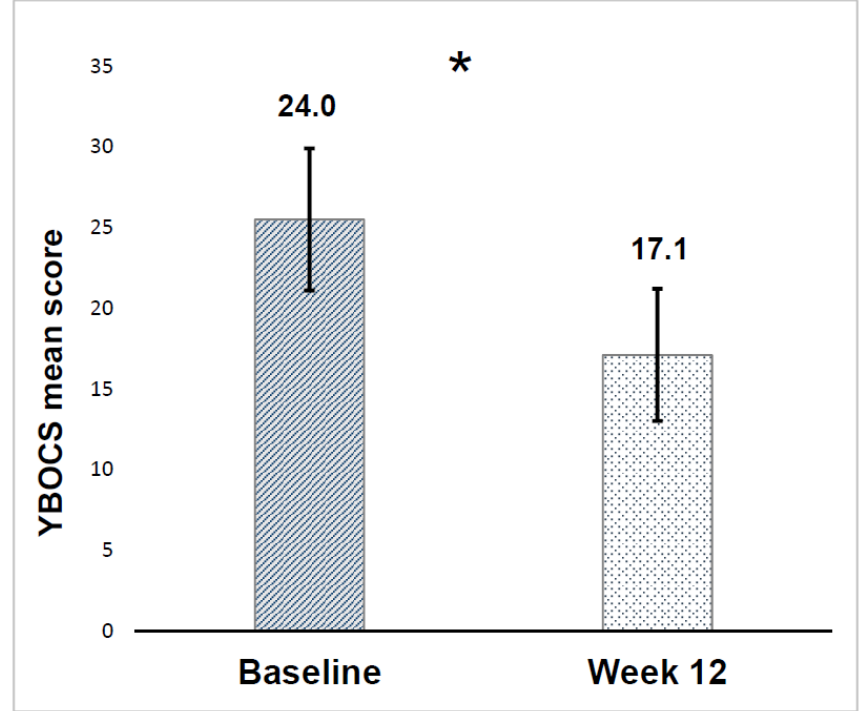
Figure 1. Yale–Brown Obsessive-Compulsive (YBOCS) score mean reduction. *: p < 0.001.